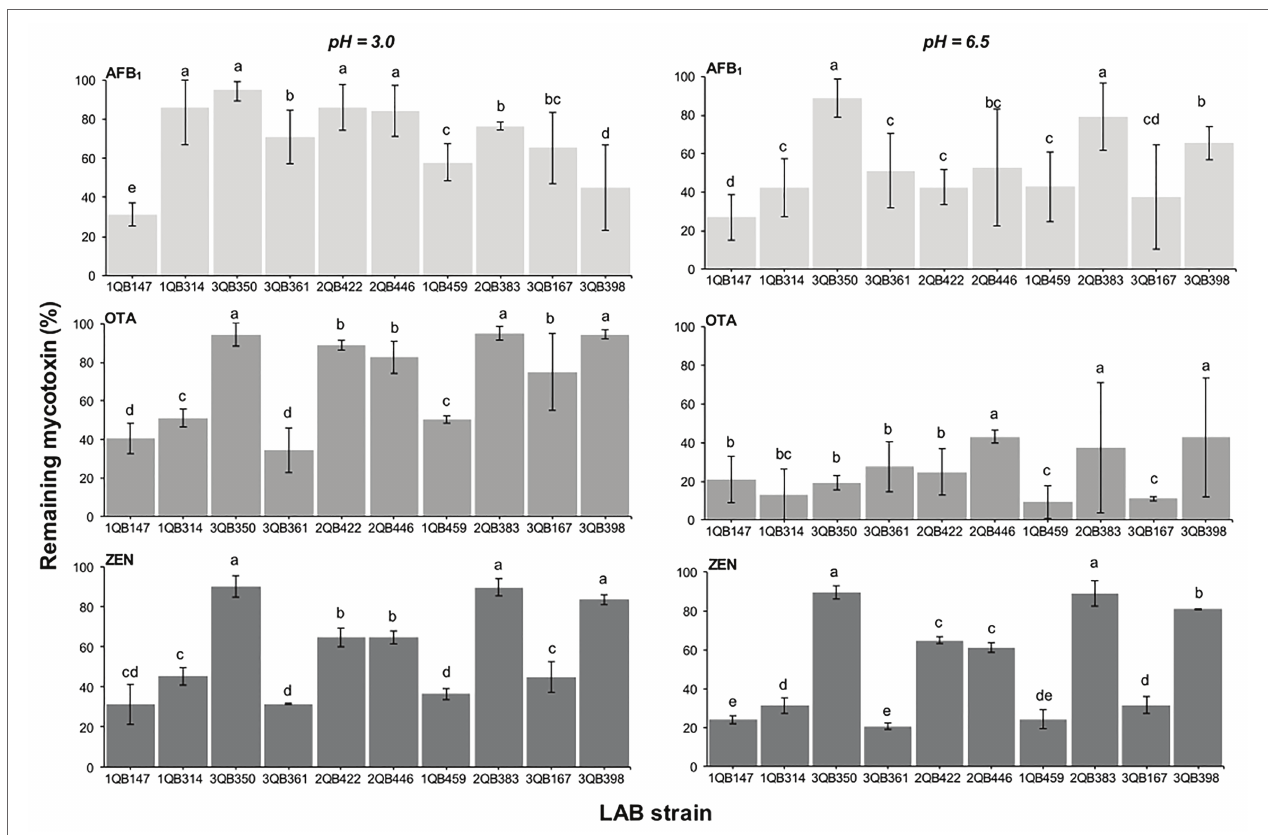
FIGURE 6 | Remaining AFB 1 , OTA, and ZEN in PPB at pH 3.0 and 6.5, after 15 min contact time with heat-inactivated LAB strains including: four strains of Lactiplantibacillus plantarum (former Lactobacillus plantarum , comprising strains 1QB147, 1QB314, 3QB350, and QB361), two strains of Levilactobacillus brevis (former Lactobacillus brevis , comprising strains 2QB422 and 3QB446), and four strains of Levilactobacillus spp. (former Lactobacillus sp., comprising strains 1QB4593, 2QB383, 3QB167, and QB398). Initial concentrations of mycotoxins in PPB were 1.0 ng ml −1 (AFB 1 , OTA) and 2.0 μ g ml −1 (ZEN). Results (% in relation to controls) are expressed as mean values of three independent experiments, with SDs indicated as error bars. Bars with no common letters differ significantly ( p <